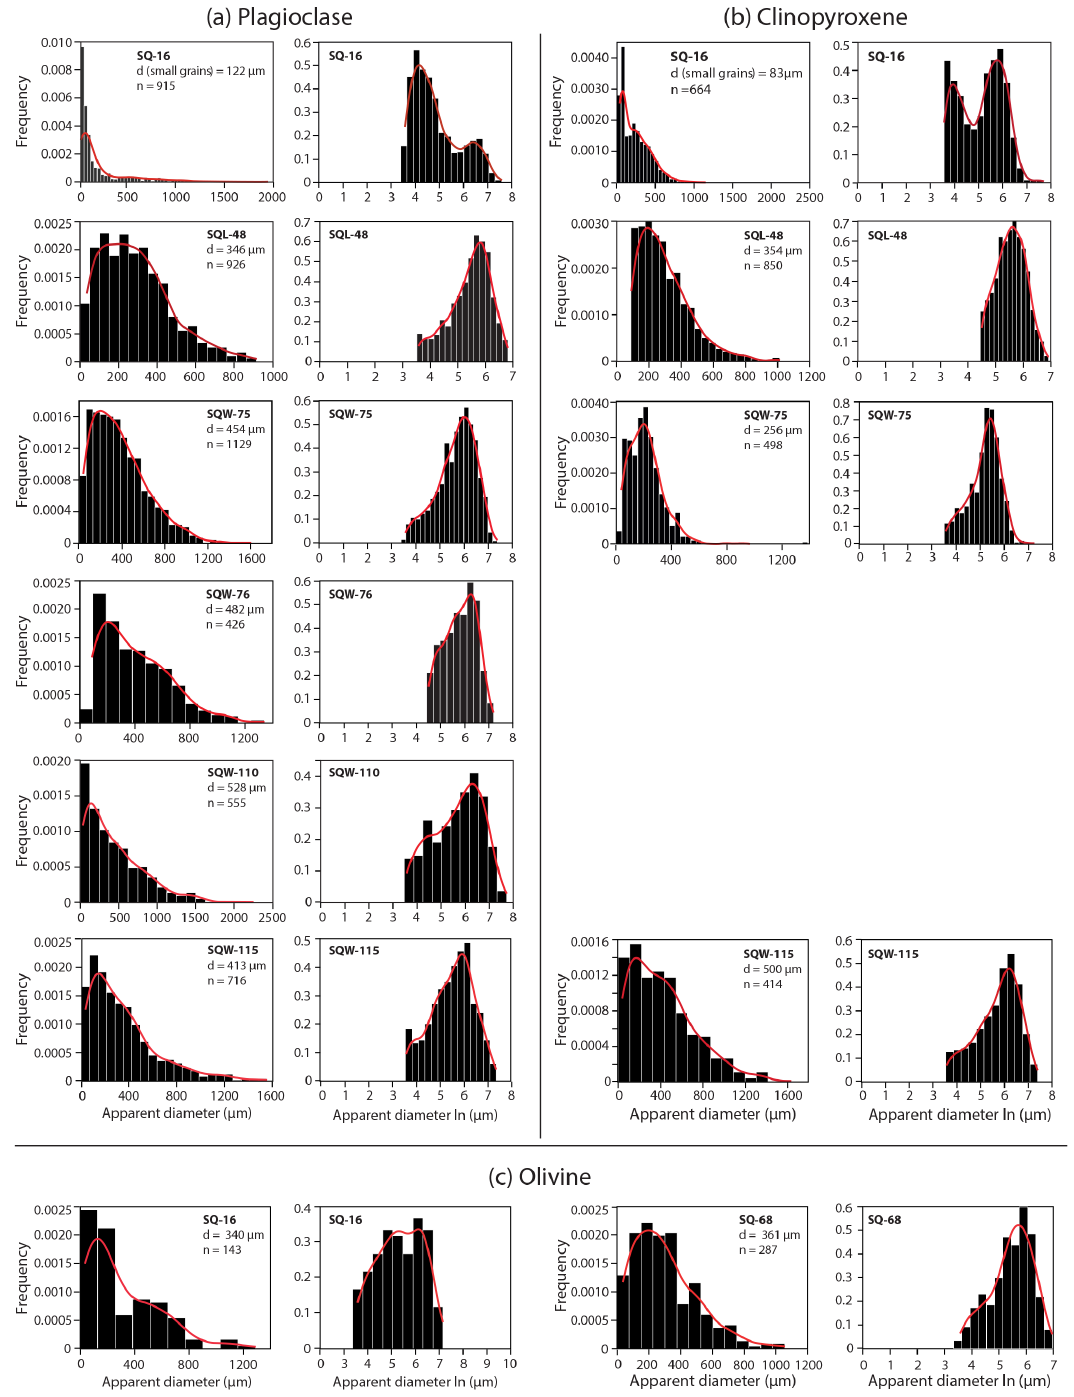
Figure 8. Recrystallized grain size distributions of (a) plagioclase, (b) clinopyroxene, and (c) olivine in granulites SQ-16, SQL-48, SQW-75, SQW-76, SQW-110, and SQW-115, as well as for lherzolite SQ-68. In each sample, plots show the number-weighted frequency distribution of the grain size (left) and the logarithmic grain size (right). Grain size is estimated with the equal circular diameter (ECD) method. The red lines show the Gaussian kernel density